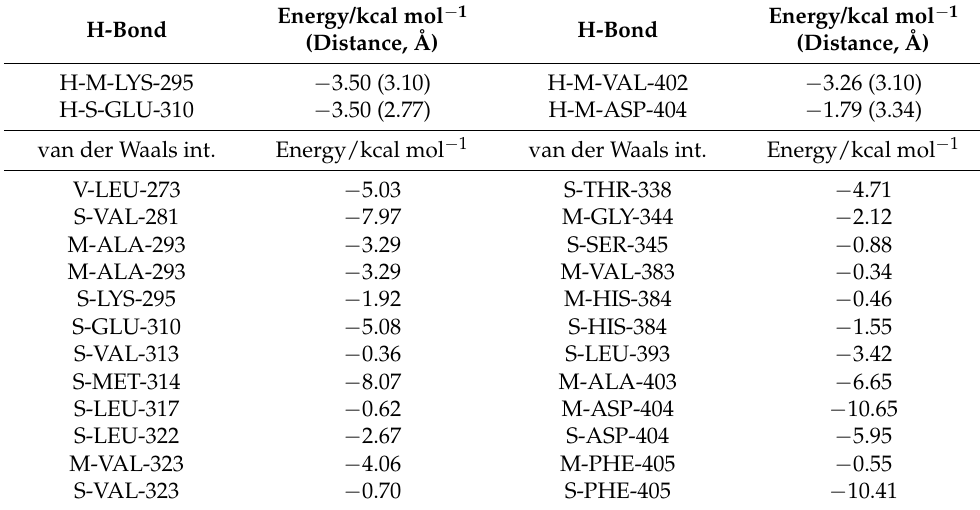
Table 5. Interaction energies between the active site residue c-Src and compound 12d (M = main chain; S = side